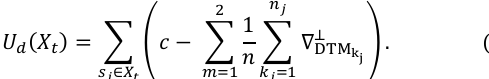
Figure 3: The overlapping area for all pairs of segments is calculated if both segments do not belong to the same